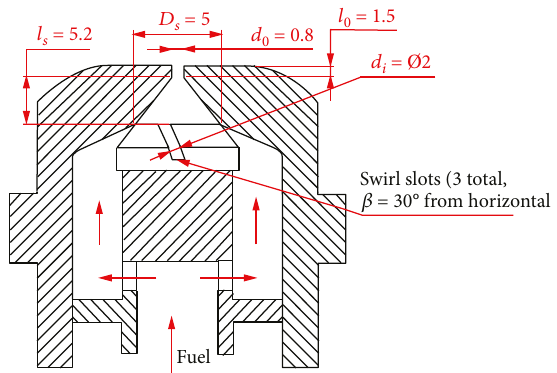
Figure 1: Schematic of a pressure-swirl nozzle. (All dimensions are in